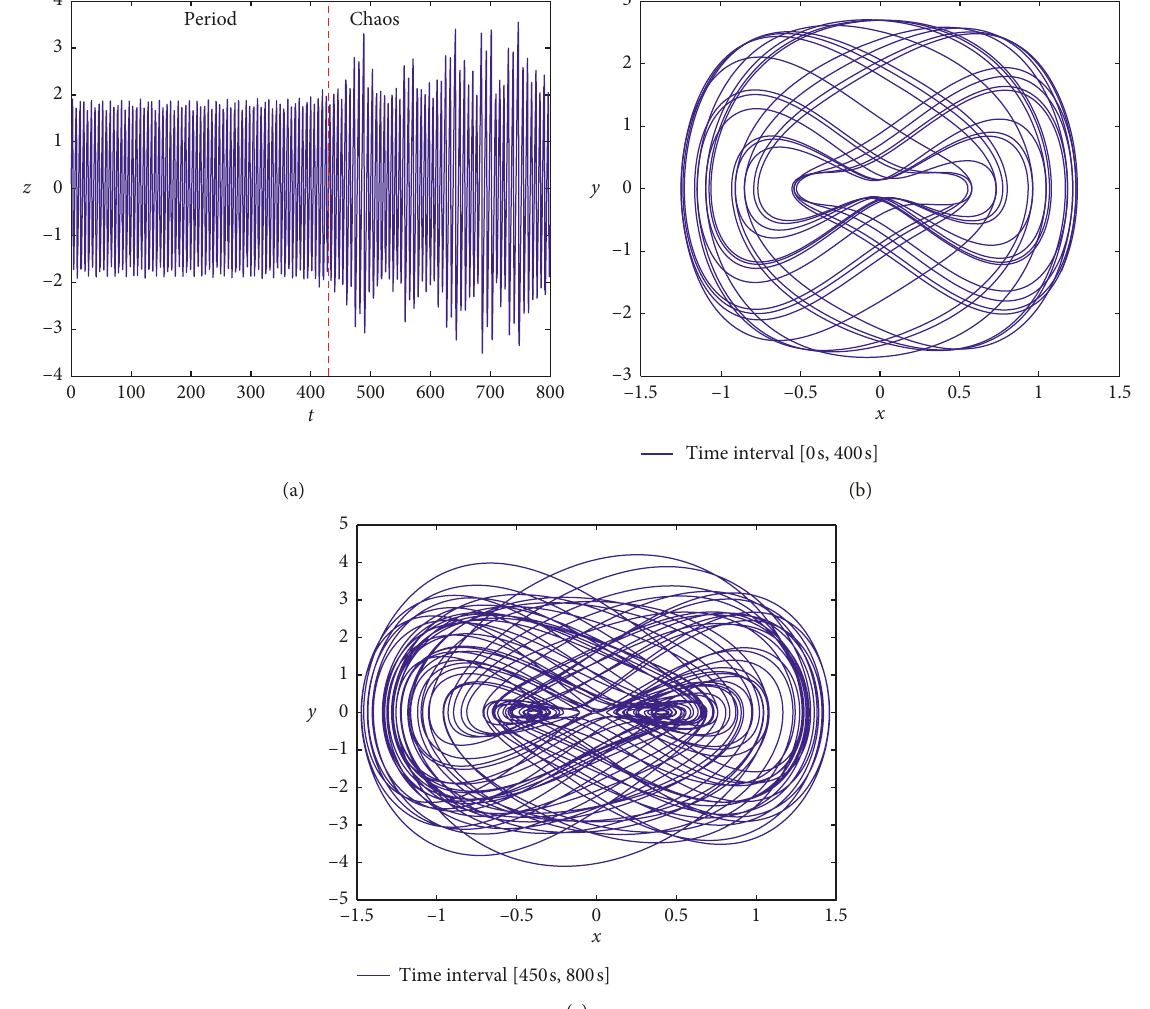
Figure 8: (a) Time-domain waveform of z in the region of [0s, 800s]; (b) the phase portrait in time interval of [0 s, 400s]; (c) the phase portrait in time interval of [450 s, 800